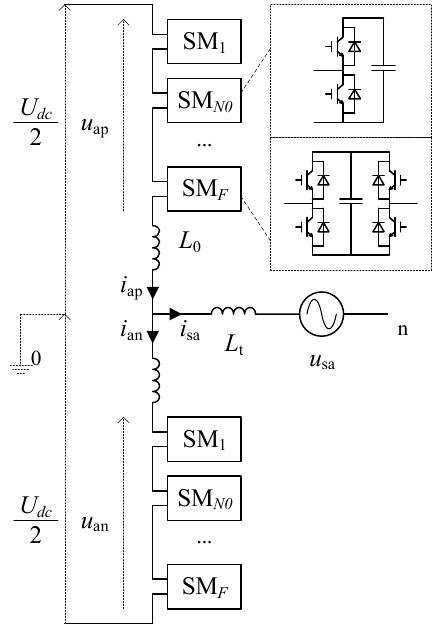
Figure 1. Illustration of the hybrid MMC.